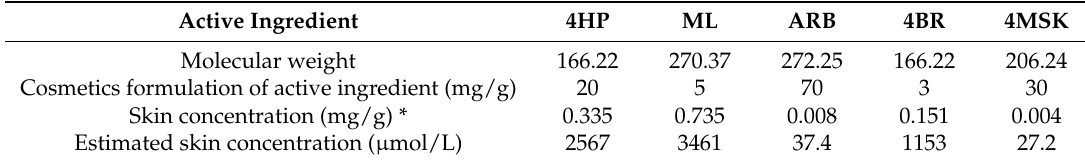
Table 2. Skin concentrations of test ingredients determined from Potts & Guy’s skin permeation coefficient prediction equation.